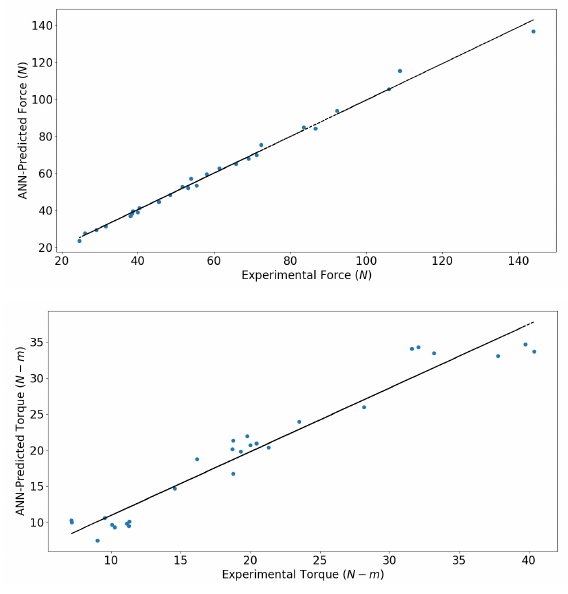
Figure 12. Scatter plot comparison of torque values To test the accuracy of the created ANN models in terms of predicting the output parameter for a given set of input parameters, the R 2 coefficient of correlation was calculated for each output parameter. In each case, the R 2 values for both the testing data set as well as the overall data set were calculated. The obtained values are found to be close to unity, indicating that the created ANN models were able to accurately predict the output parameters using the given control parameter data while robustly accounting for possible random variation in the data. The calculated R 2 values are shown below. Table 2. R 2 values for testing and total